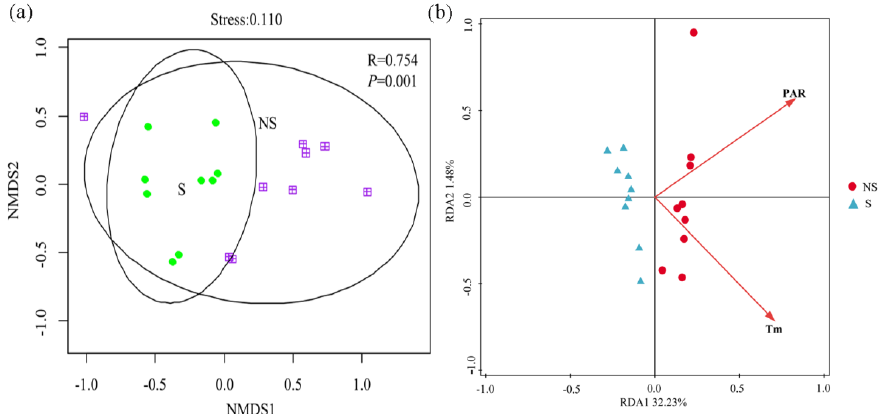
Figure 2. Comparison of diversity ( a ) and performance ( b ) of plant community in S and NS. Significance levels are denoted with * p < 0.05. The same as below for the significant levels.